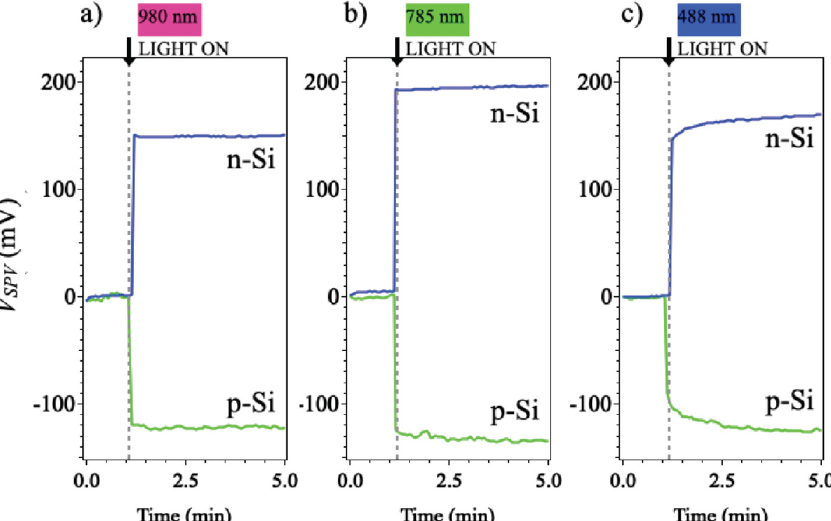
Fig. 2. The SPV results measured on bare c-Si substrates (n-type blue and p-type green) using KPFM method. The direction of SPV does not depend on the illumination wavelength and results in positive SPV for n-Si and negative SPV for p-Si.